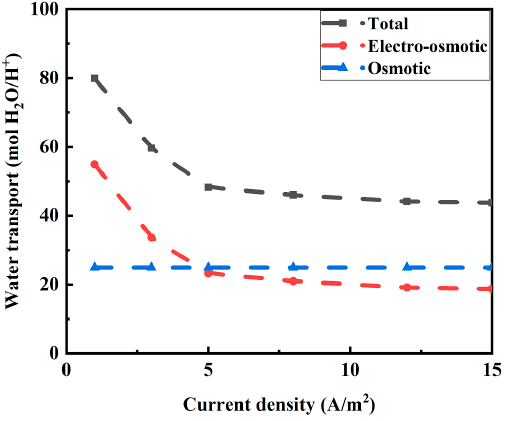
Figure 4. Calculated delivered water (mol/H + ) based on the values of t w and D w determined in this research as a function of the employed current density.